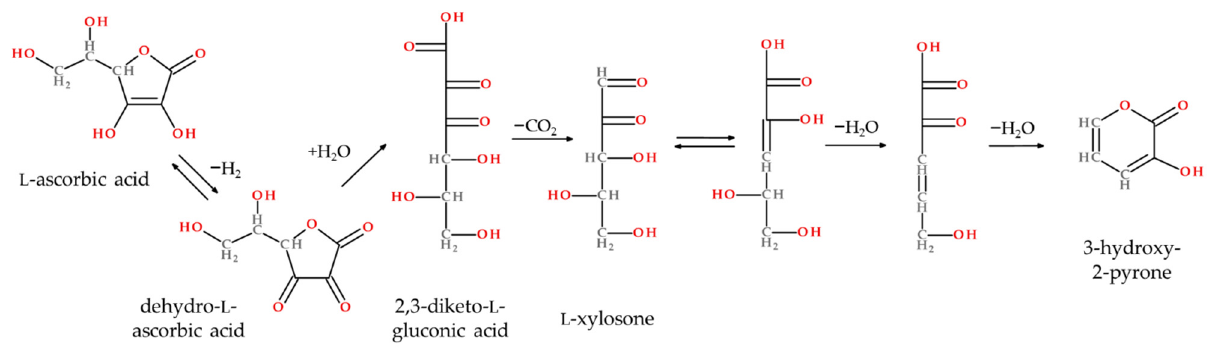
Figure 3. Formation of 3-hydroxy-2-pyrone from L -ascorbic acid (modified from [47,48]). Geraniol was perceived with a lower FD factor in the pure coffee pulp distillate (FD 16), than in the puree (FD 1024). This might be explained by a release of geraniol through acidic hydrolysis during the thermal processing of the puree. In fruits, terpenes such as geraniol are often found to be glycosidic: bound and released by enzymatic or acidic hydrolysis [36]. Geraniol was also identified in a mixture of the pulp and wastewater from the depulping and demucilage processing of the coffee beans ( Coffea ara- bica L., variety Catuaí 99 vermelho) [49]. An increase in its concentration was observed after fermentation with yeast ( Haseniaspora uvarum UFLA CAF76) [49].